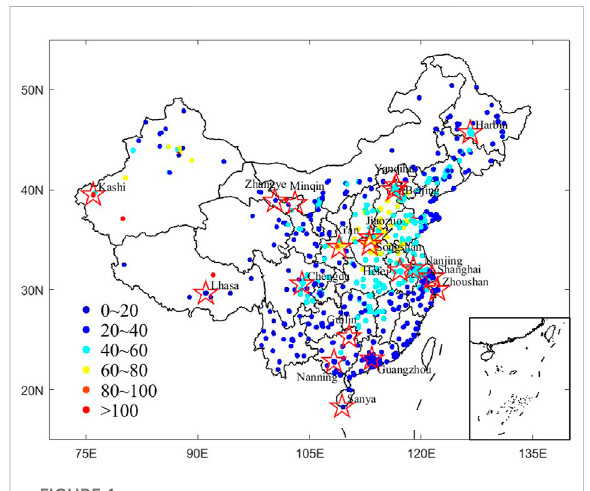
FIGURE 1 Locations of SONET sites (red pentagrams) and annual PM